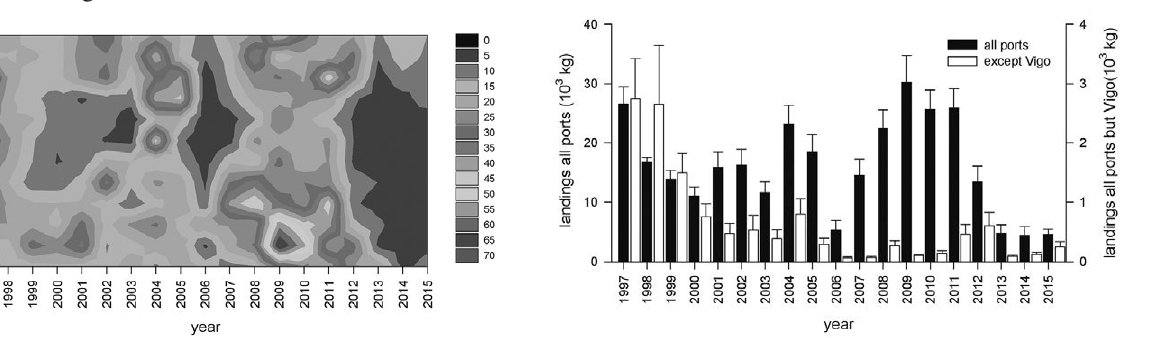
Fig. 5. – Loligo vulgaris . Monthly average and standard deviation of official landings of squid (10 3 kg) in the Ría de Vigo, excluding the landings from the fish market of the port of Vigo and including those of Aldán-Hio and Bueu, between 1997 and 2015 (black dots) and between 2011 and 2015 (white dots).